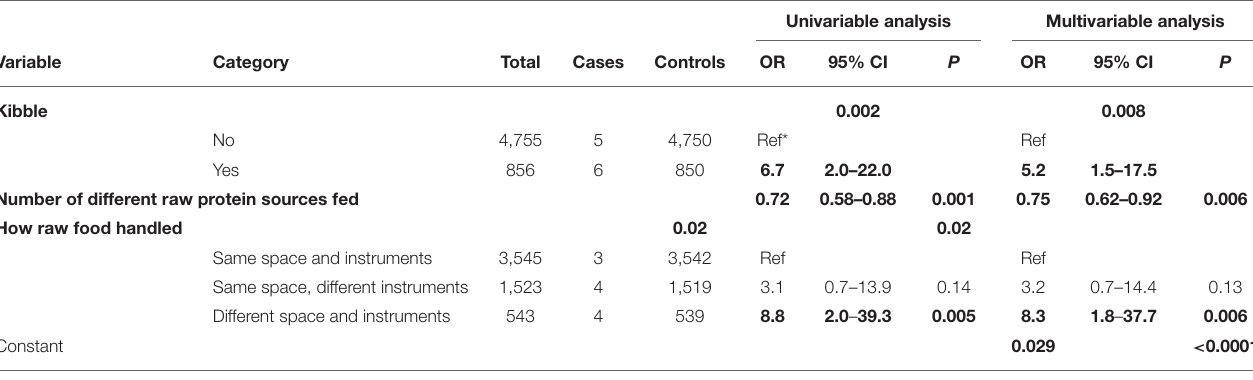
* Ref = Referent category. Nagelkerke R Square = 0.165.